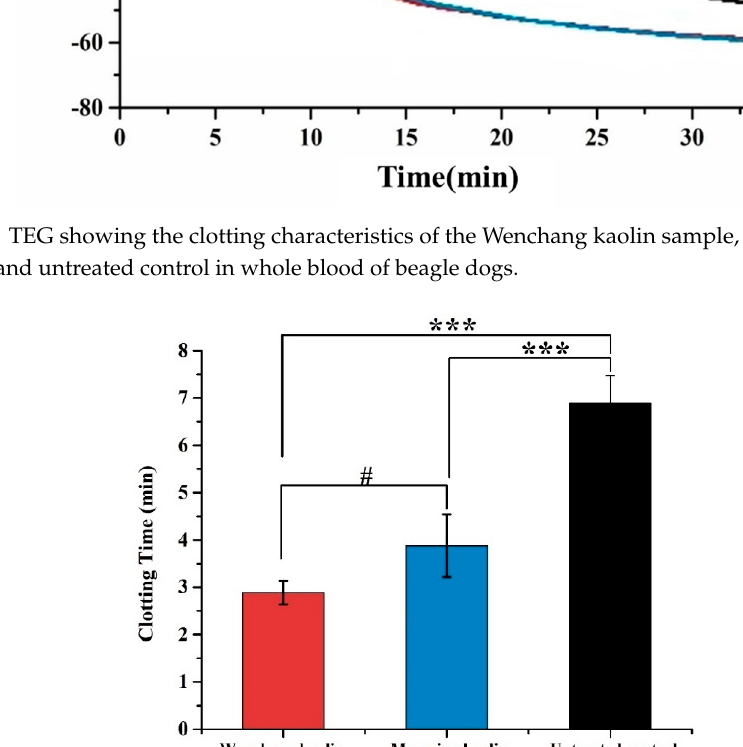
Figure 6. TEG showing the clotting characteristics of the Wenchang kaolin sample, Maoming kaolin sample, and untreated control in whole blood of beagle dogs.